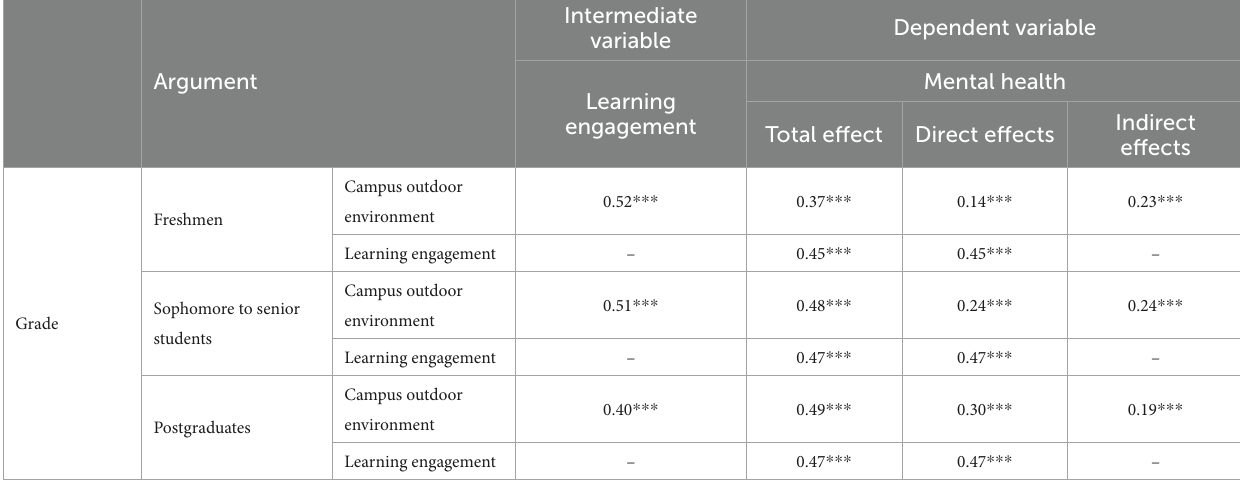
TABLE 8 Comparison of path coefficients for different university student groups model.